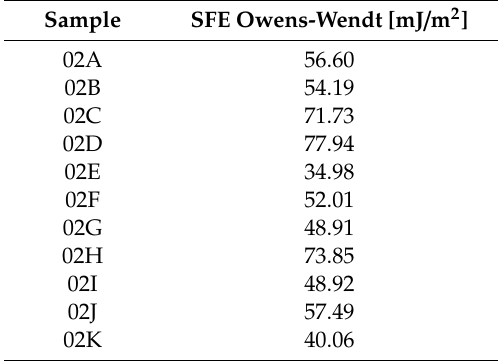
Table 10. Values of surface free energy of Al 2 O 3 coatings after thermo-chemical